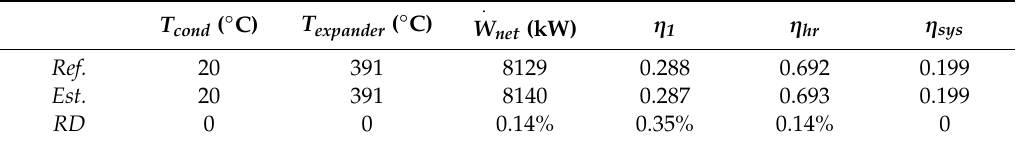
Table 6. Comparison of the results calculated in this paper with the data from reference [42]. RD : relative deviation.